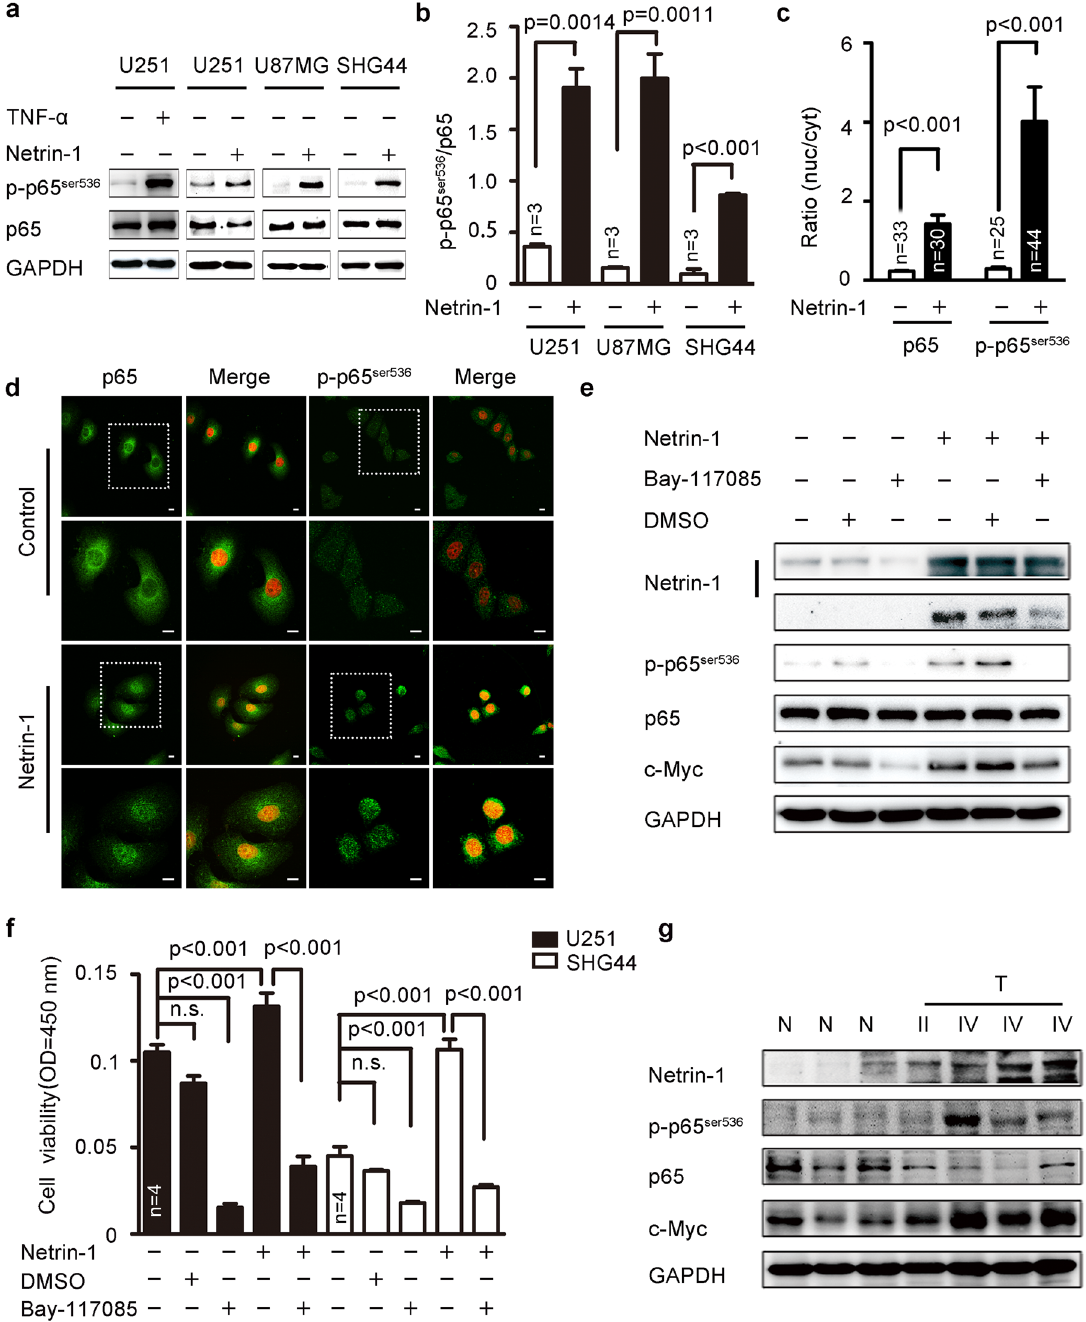
Figure 6. Netrin-1 could activate of the NF- κ B signaling pathway. ( a ) Western blotting analyses of p65 ser536 phosphorylation in U87MG, U251 and SHG44 cells in response to netrin-1 stimulation. TNF α was used as a positive control. ( b ) Quantification of p65 ser536 phosphorylation using Gel-Pro Analyzer 4 software. Phosphorylation of p65 ser536 was normalized to total of p65 expression. ( c ) Quantification of cytosolic and nuclear p65 and phosphorylation of p65 ser536 immunofluorescence results using Image J. ( d ) Subcellular localization of p65 and p65 ser536 phosphorylation in U251 cells in the absence or presence of netrin-1. DAPI staining is red. Scale bar: 10 μ m. Boxed areas in the upper panels were magnified and shown in the corresponding lower panels. ( e ) U251 cells were pretreated with the NF- κ B-specific inhibitor Bay117085 (15 µ m/L) for 3 h prior to treatment with recombinant human netrin-1 for 30 min. Cells were pretreated with DMSO as a negative control. Netrin-1, p65 ser536 and c-Myc were detected by western blotting. GAPDH was used as a loading control. ( f ) U251 and SHG44 cells were treated with the NF- κ B-specific inhibitor Bay117085 (15 µ m/L) for 3 h prior to treatment with recombinant human netrin-1 for 48 h. Cell viability was determined by CCK-8 assay. ( g ) Western blotting analyses of netrin-1, p65 ser536 , total p65 and c-Myc in glioma tumor tissues (T) and normal brain tissues (N) from clinical samples. The data are shown as the mean ± SEM. n.s., P >